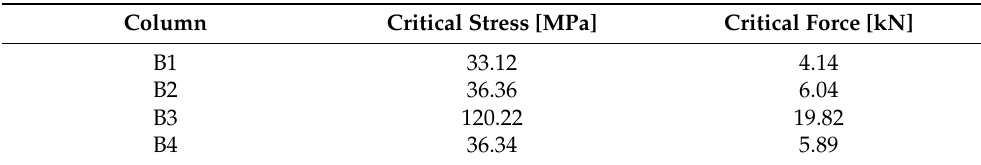
Table 8. Values of critical stresses and critical forces obtained from numerical simulations performed with the finite strip method.